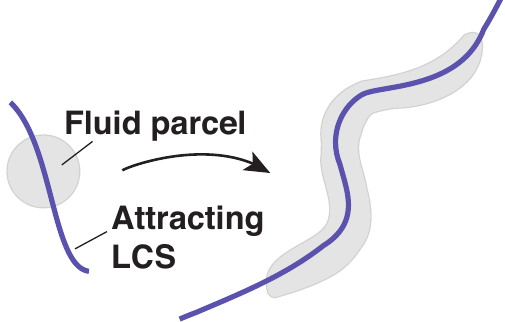
Figure 1. Schematic illustration of an attracting LCS, and its effect on a fluid parcel over a short advection